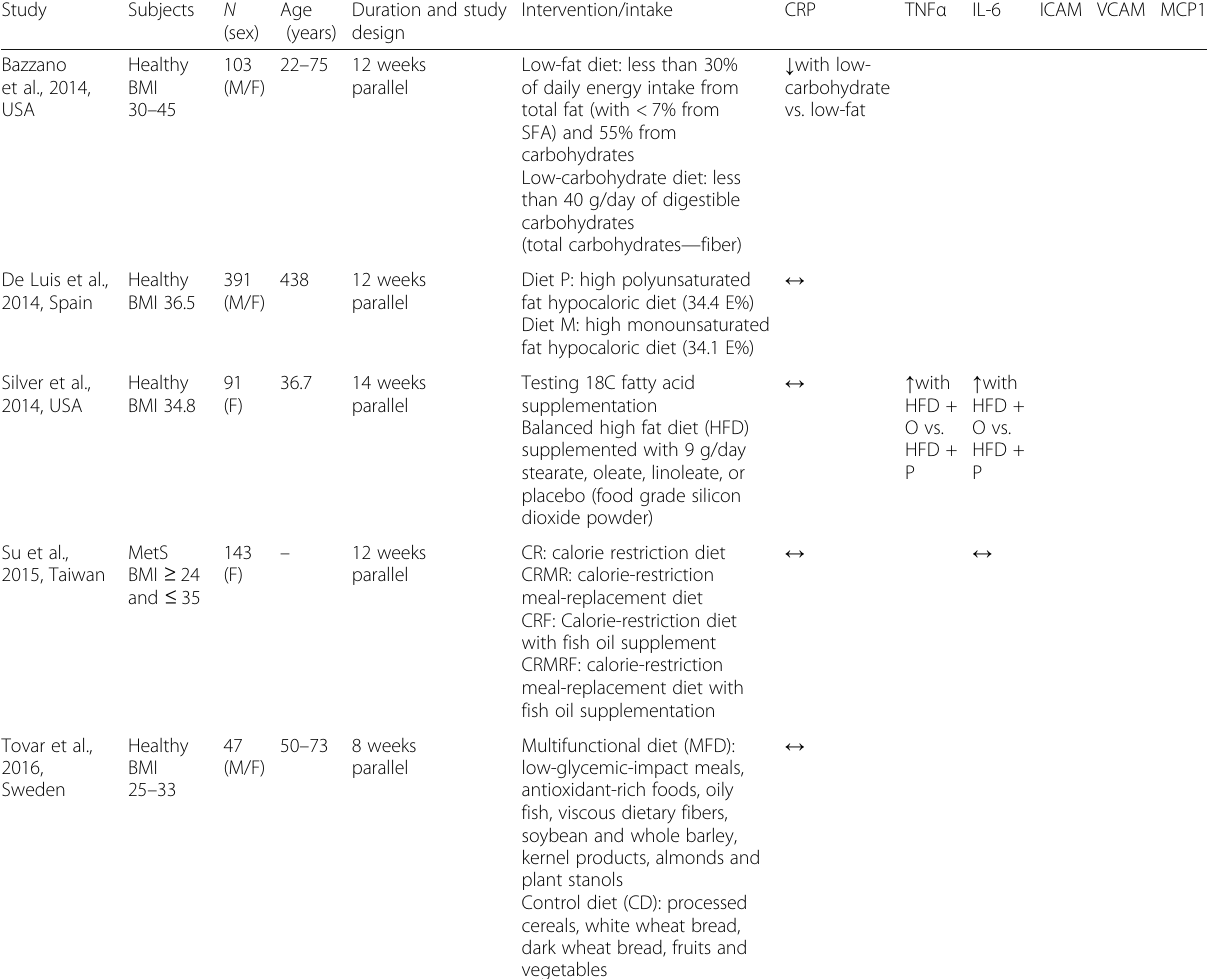
Table 2 Weight reduction studies and inflammatory response Study